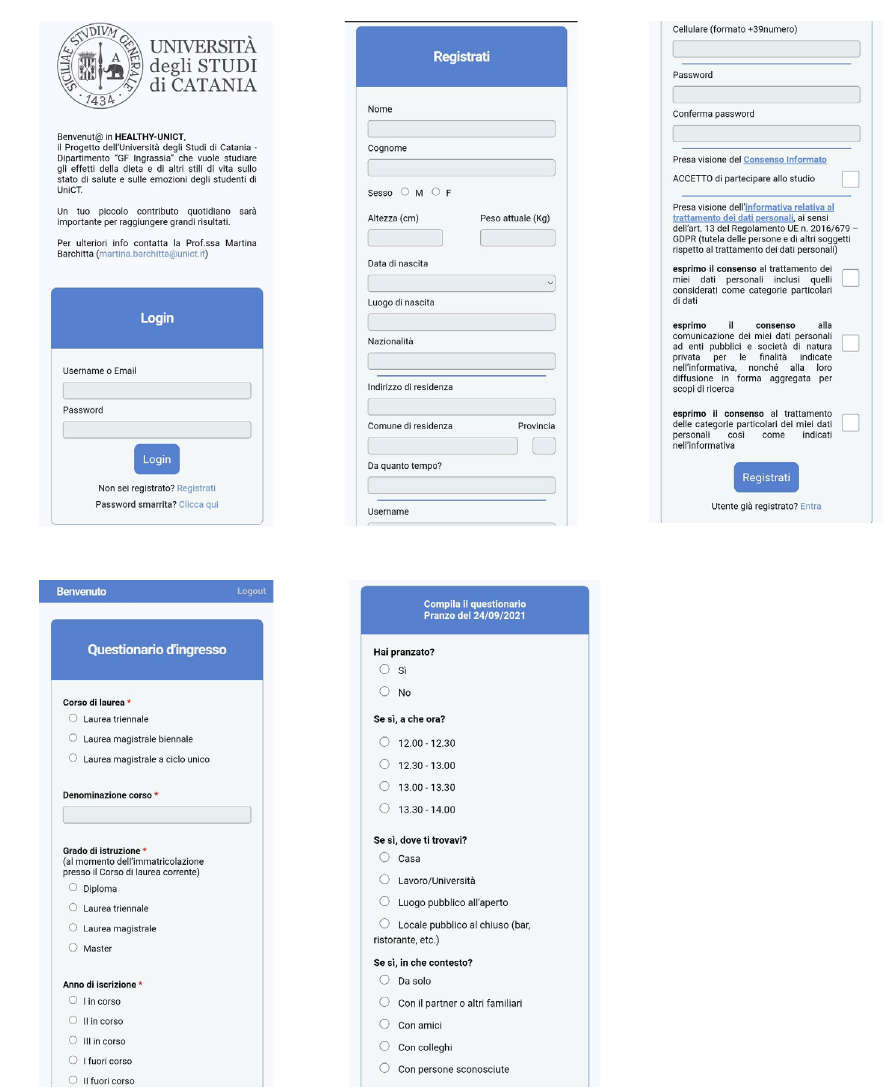
Figure 3. Participant views of the web-app from a smartphone. The web-app was conceived in Italian language to ensure full understanding of questions and surveys.